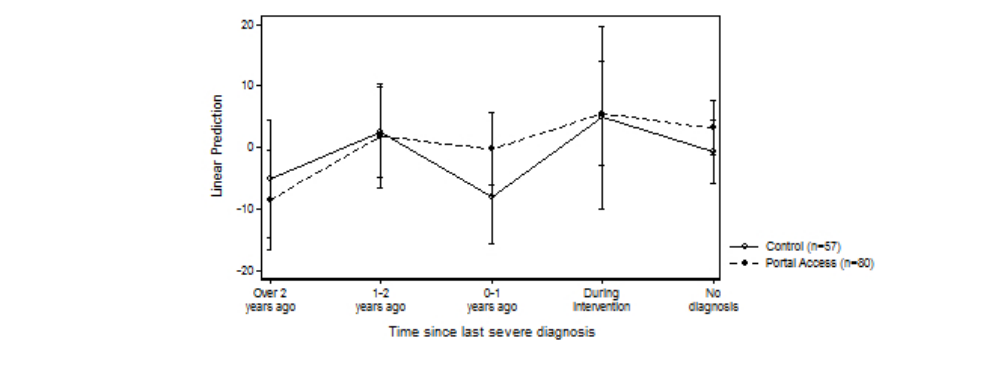
Figure 6. Group estimates for mean change in patient activation (0-100 points) in groups with different time since last severe